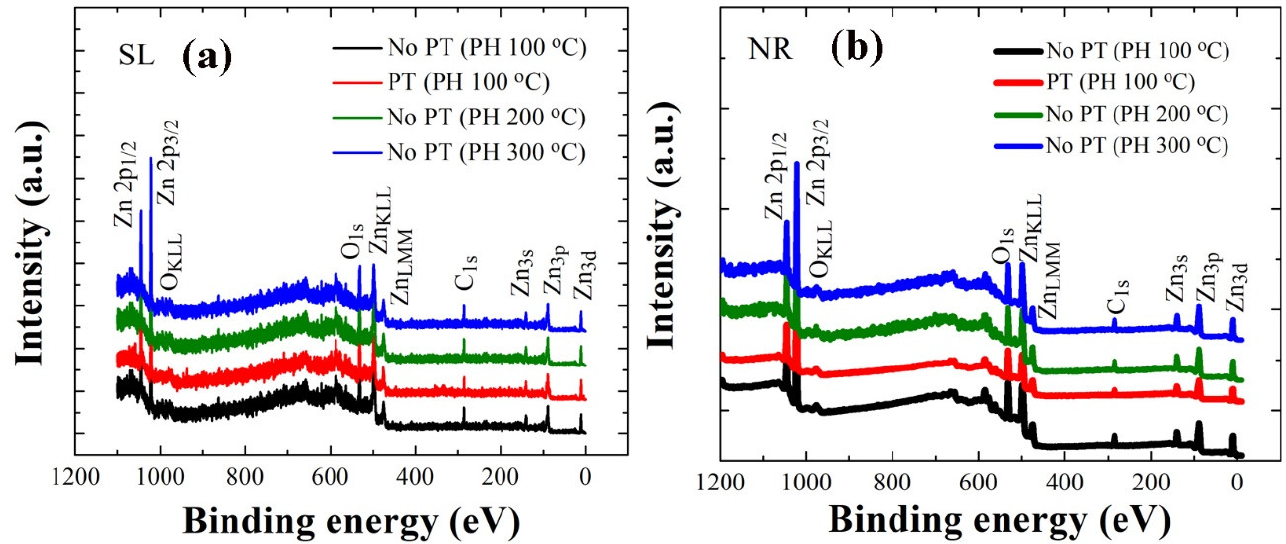
Figure 5. XPS wide scan spectra of ZnO SLs ( a ) and NRs grown on the SLs ( b ) prepared under different conditions.